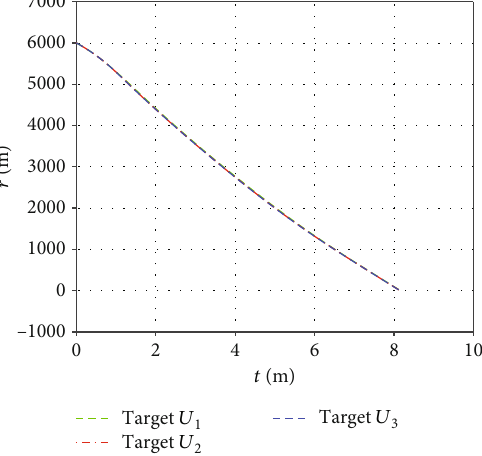
Figure 41: Relative trajectories.